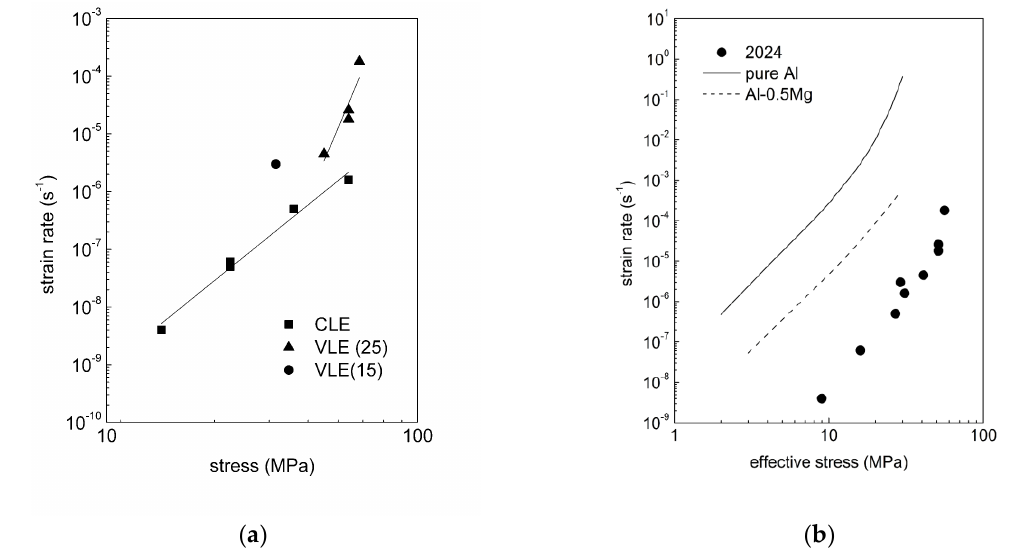
Figure 1. ( a ) Experimental values of the minimum creep rate for tests on AA2024 T3 at 315 °C [14]. CLE stands for constant load experiments. VLE stands for variable load experiments (tests during which an initial value of the applied stress, 15 or 25 MPa, was increased at the early beginning or in proximity of the minimum creep rate range). ( b ) Strain rate as a function of the effective stress σ - σ 0 for the data ( a ) compared with the response of pure Al [18] and Al-0.5Mg [19].